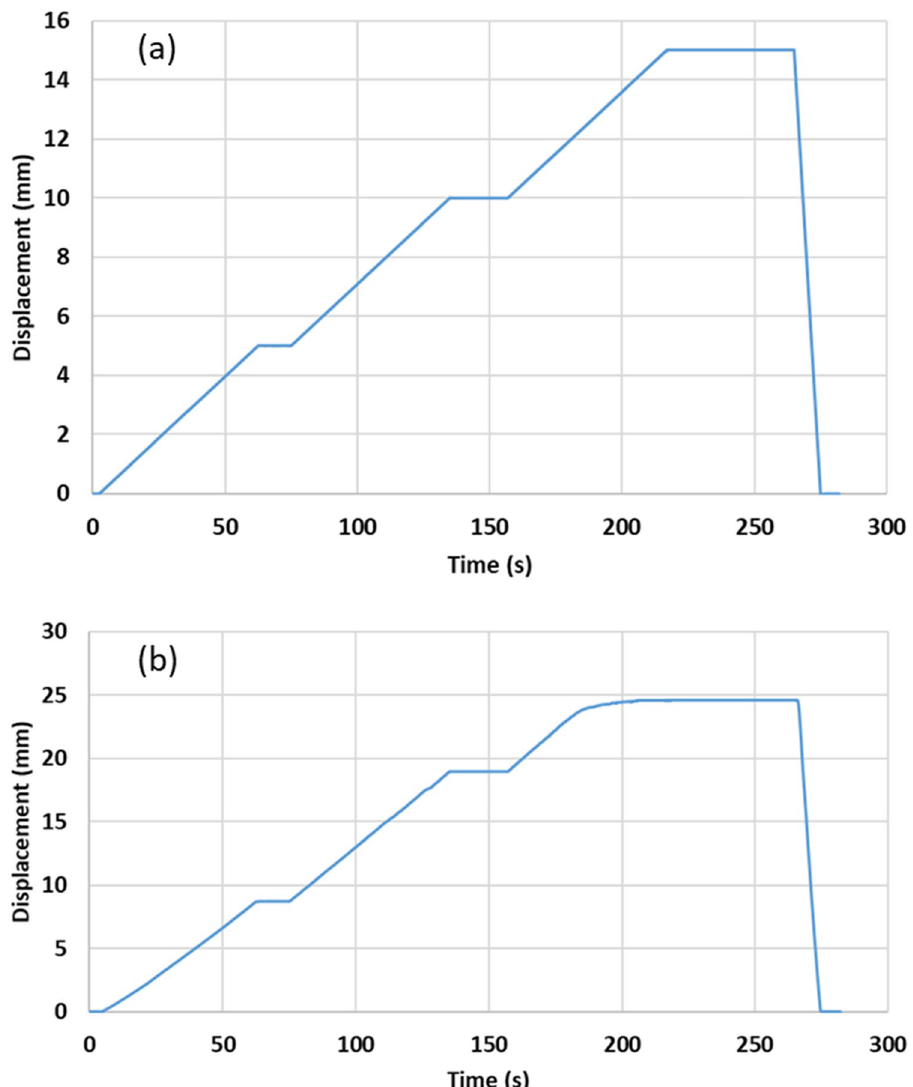
Figure 15. Longitudinal ( a ) and transverse ( b ) displacements of the honeycomb structure recorded during the